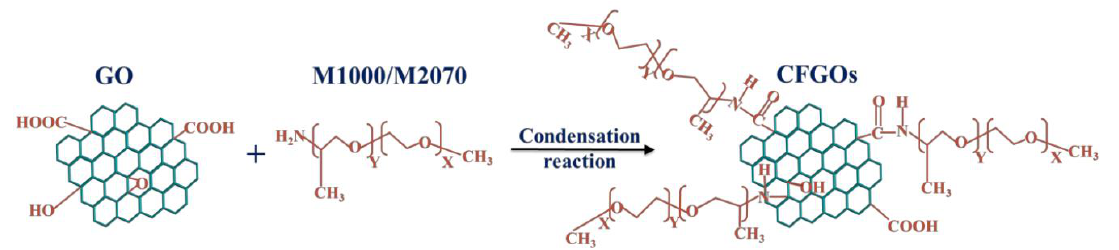
Figure 9. Schematic illustration of chemically functionalized GO. Reprinted from Ref. [91].